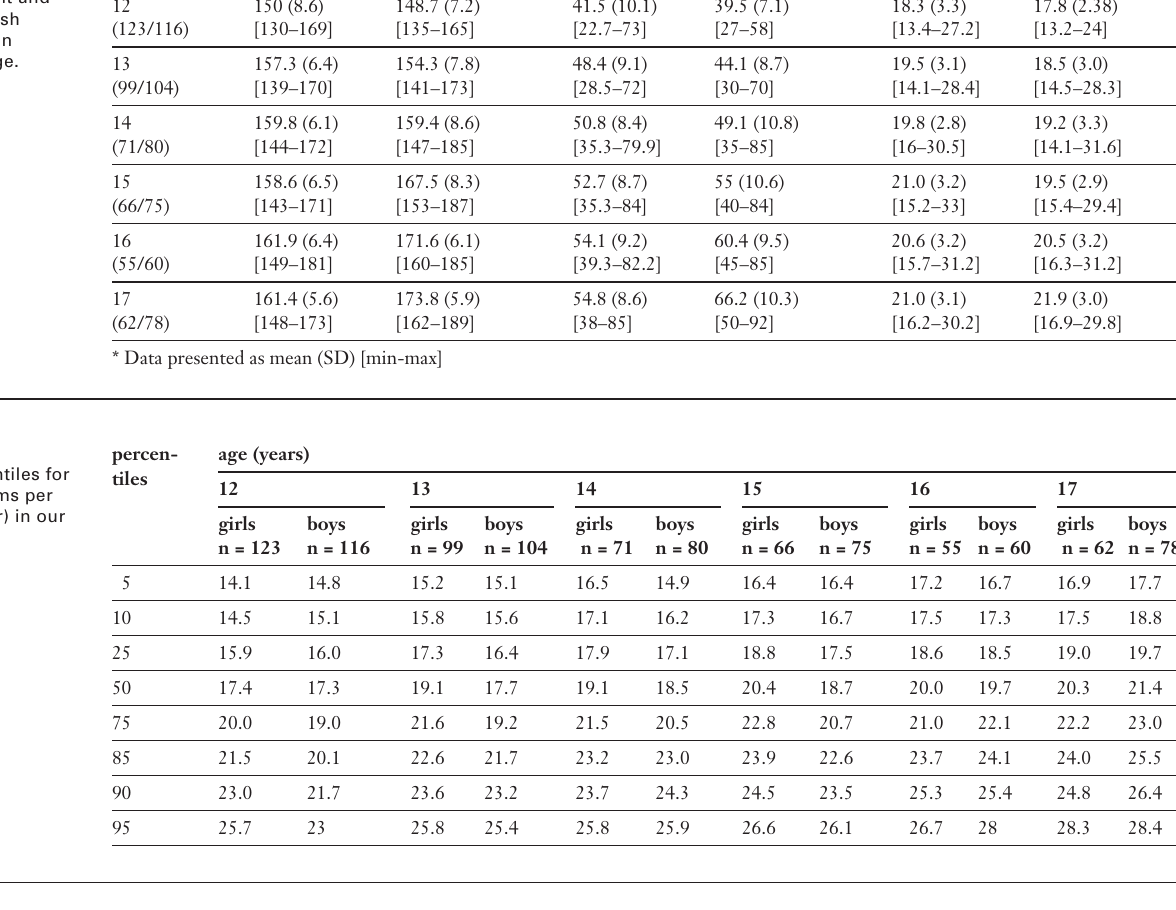
Table 1 Mean values (SD) [range] for body weight, height and BMI for Turkish adolescents in relation to age.